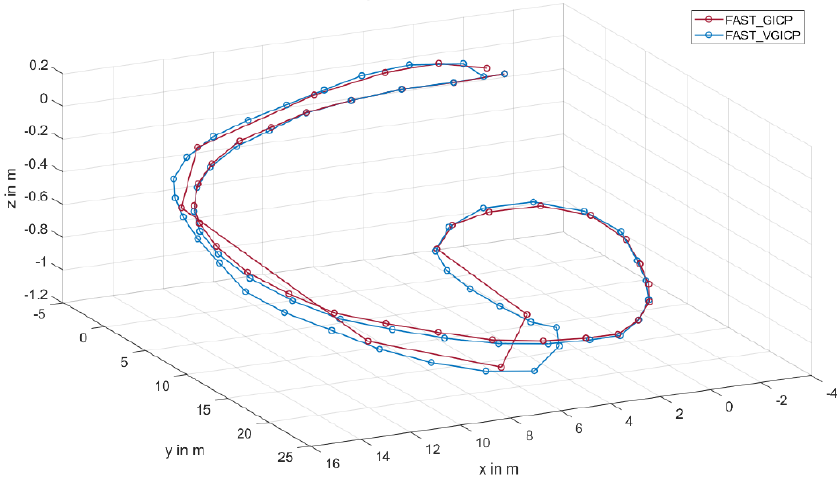
Figure 18. Height course of the trajectory determined by hdl_graph_slam with deactivated floor_detection node.